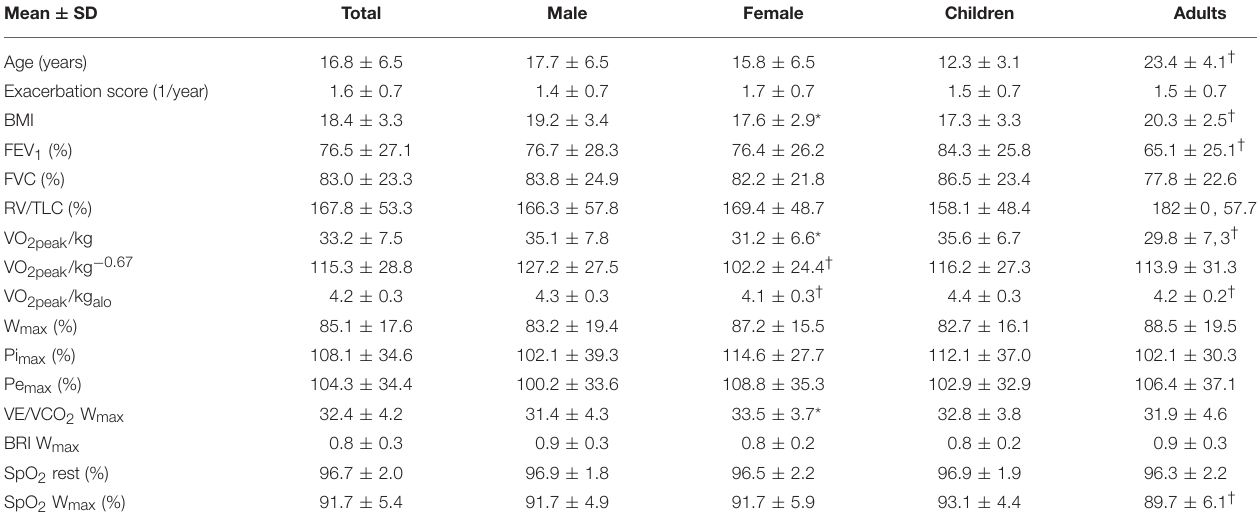
TABLE 1 | Demographic data.